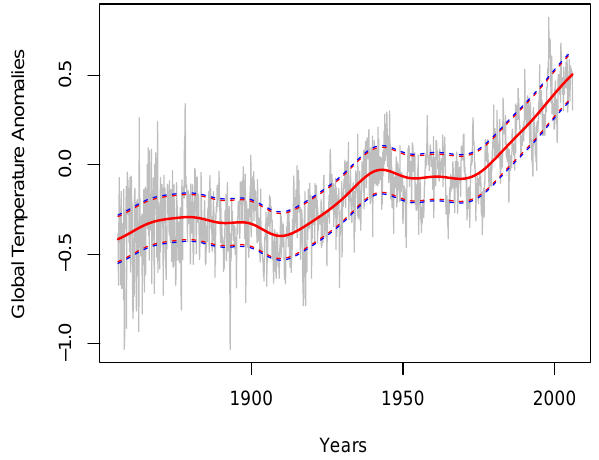
Fig. 1. Global monthly temperature anomalies ( ◦ C ) , relative to 1961–1990 (gray curve) with a trend estimate (thick red curve), a 90% SCB for the trend (dashed red curves) and calibrated 90% SCB for the trend (dashed blue